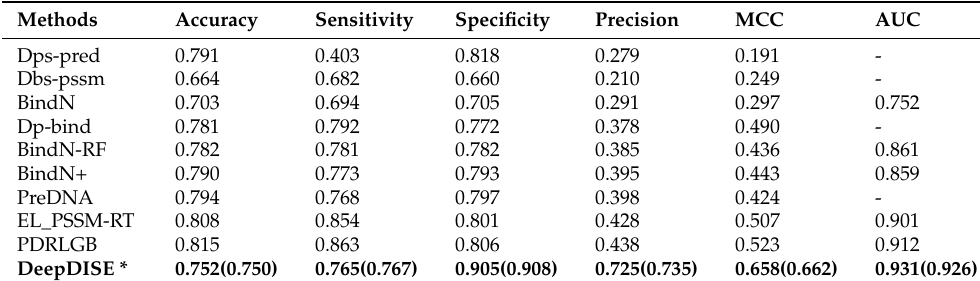
Table 2. Performance of DeepDISE compared with previous methods using PDNA62 [46].